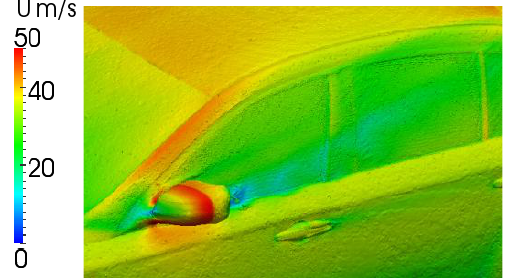
Figure 13. Velocity distribution on the side window obtained using the DSLM method at t = 0.765 s.